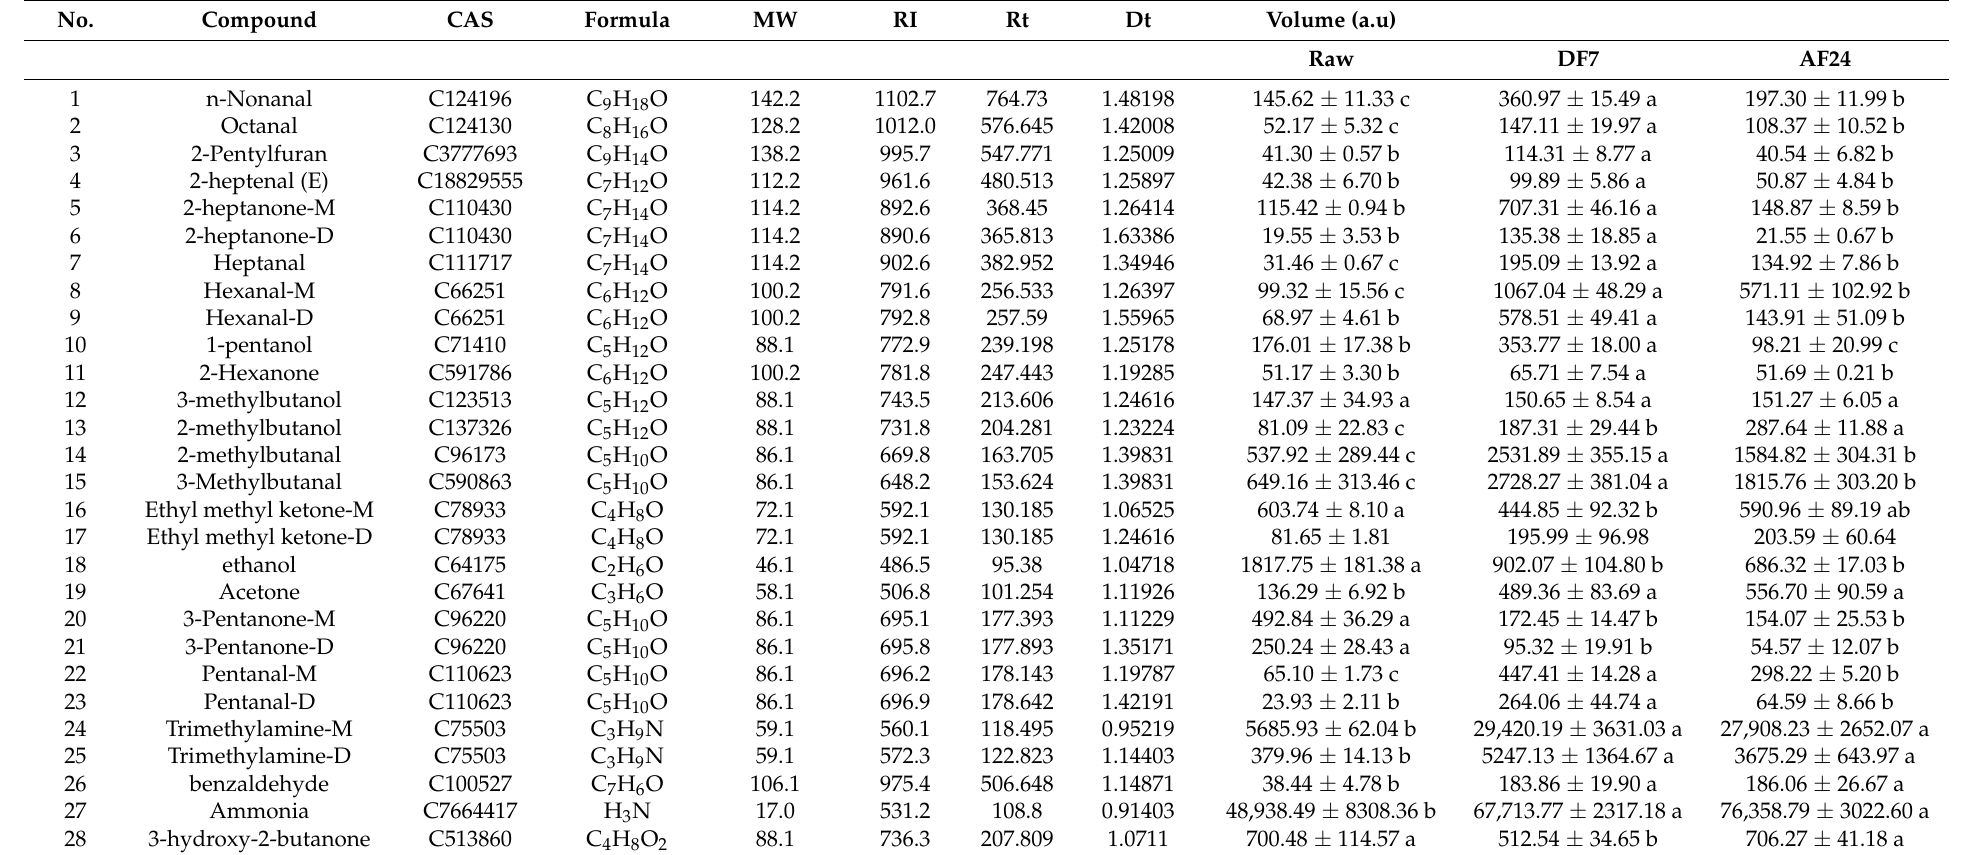
Table 2. The volatile components and relative contents of hairtail fillets in different frying methods. Data are represented as a mean ± standard deviation of three replicates. mean values with different lower-case letter in the same row correspond to significant differences at p < 0.05. Raw, untreated; DF7, deep frying for 7 min; AF24, air frying for 24